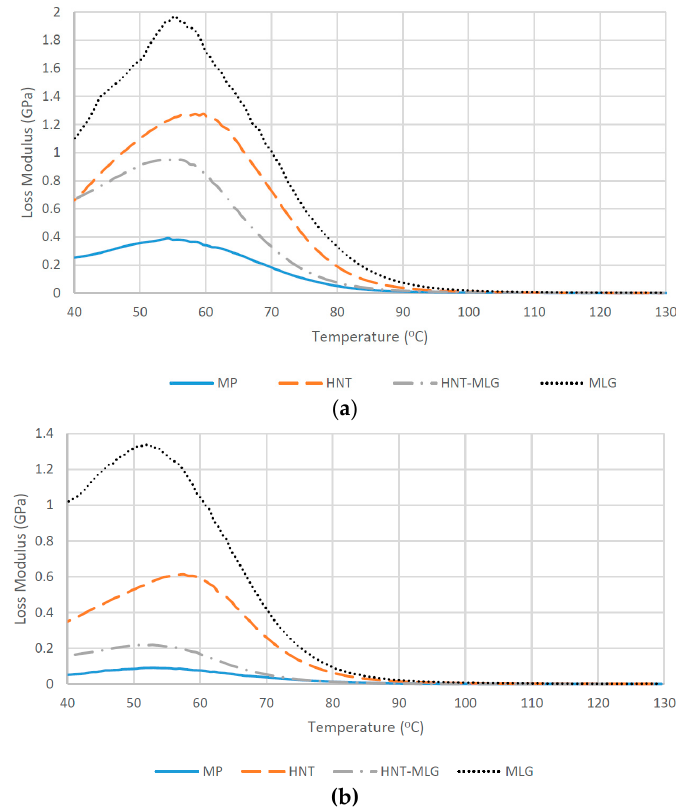
Figure 4. Storage modulus of nanocomposites in dry conditions ( a ) and after water exposure ( b ).